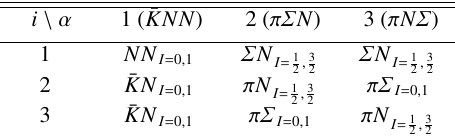
Table 3. Interacting two-body subsystems for three partition ( i ) and three ‘particle’ channel ( α ) indices. The interactions are fur- ther labelled by the two-body isospin values, entering the AGS equations with total three-body isospin I = 1 /